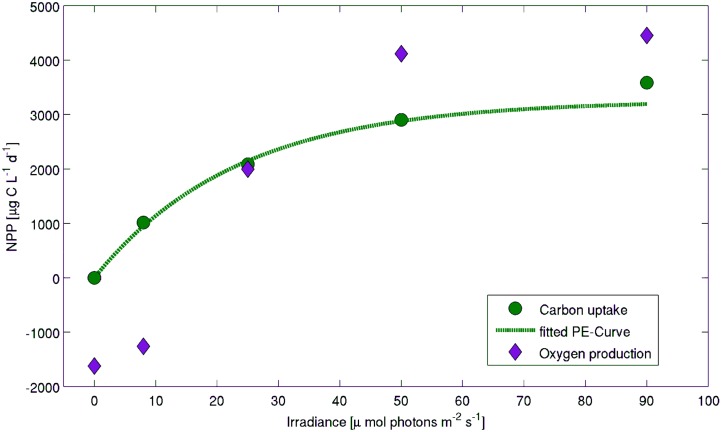
Photosynthesis vs Irradiance curve of Melosira arctica algal slurry (M5).Carbon uptake measured with the 14C radioactive isotope method (green circles) and oxygen production or consumption using optodes (purple diamonds) of the algal aggregate slurry from the Melosira arctica aggregate used for the buoyancy experiment (Fig. 5). The threshold irradiance for oxygen production is around 20 µmol photons m−2 s−1. Oxygen rates have been transformed to carbon equivalents using the photosynthetic quotient of 1.25 to improve the visualization of the two different methods used to measure NPP.